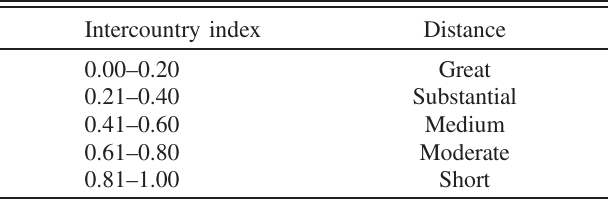
TABLE II. Criteria used to estimate distance between Italian and Greek educational